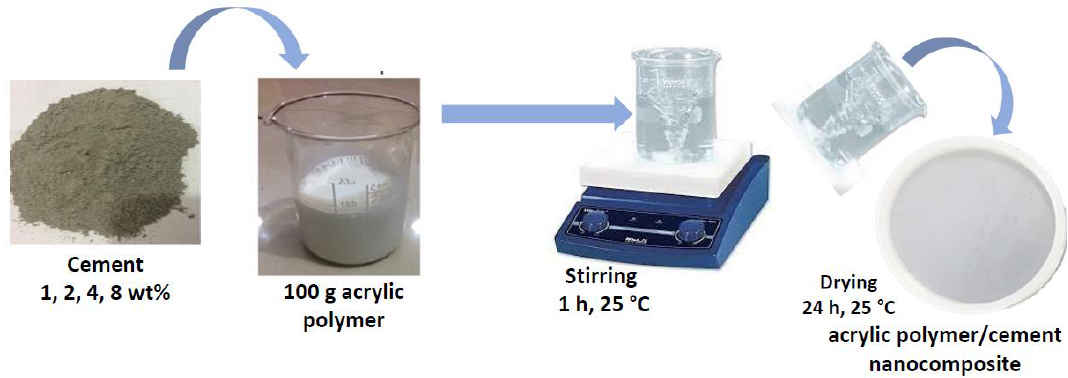
Figure 1. A schematic shows the procedures for preparing acrylic polymer